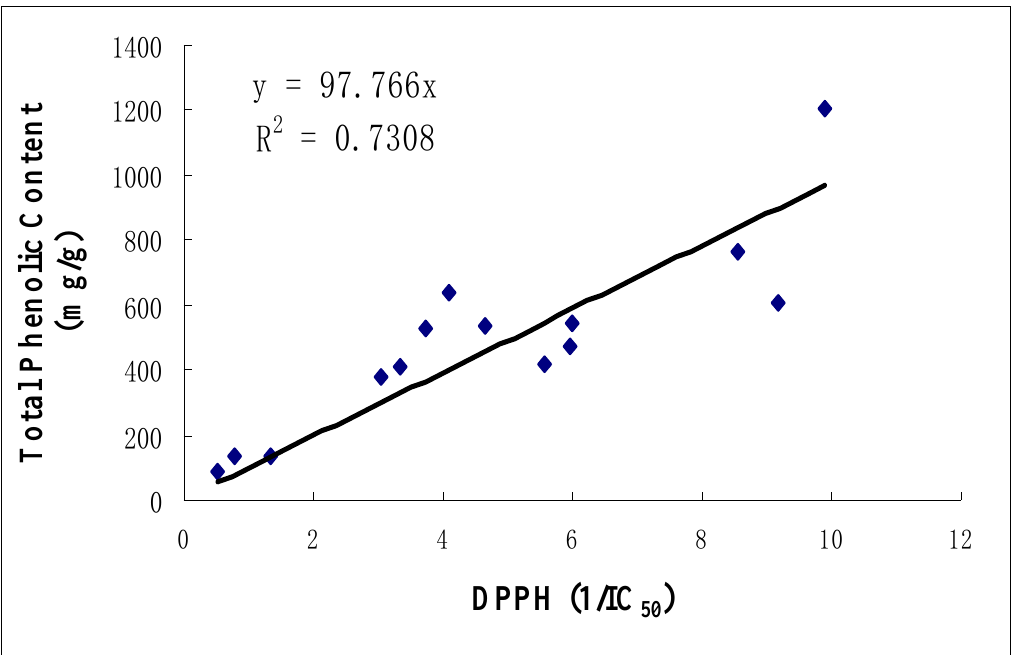
Figure 1. Correlation between DPPH scavenging activity and total phenolic content.